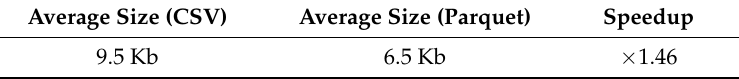
Table 4. Average file size before and after